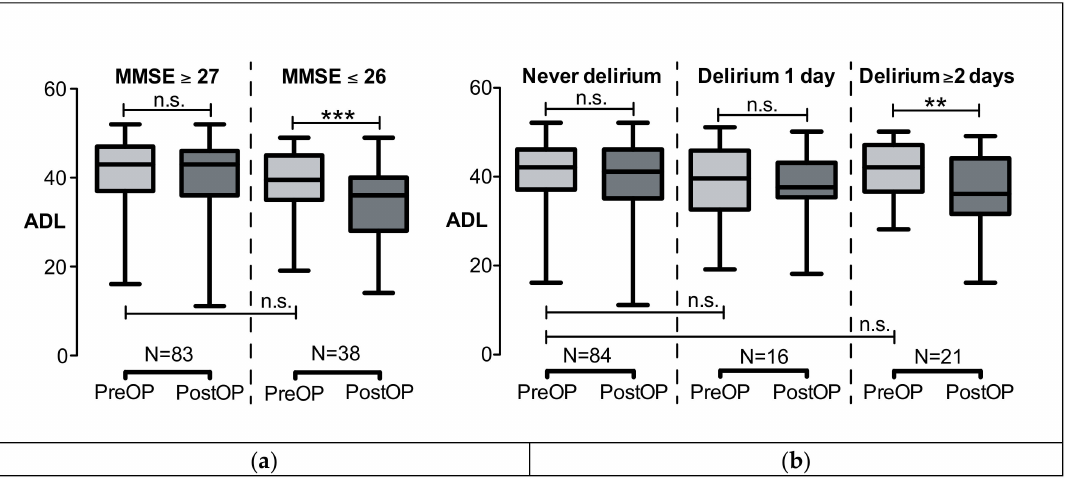
Figure 2. ADL before (preOP) and half a year after cardiac surgery and intensive care (postOP). ADL did not pre-operatively significantly di ff er between groups. ( a ) ADL was divided into MMSE ≥ 27 or MMSE ≤ 26 before surgery. ADL significantly declined only in the MMSE ≤ 26 group, ADL remained stable in the MMSE ≥ 27 group. ( b ) ADL was divided into whether patients had no delirium or 1 day or ≥ 2 days of delirium. ADL significantly declined if the delirium lasted ≥ 2 days. Data are shown as boxplots (median; minimum, maximum; 25% and 75% quartile). *** p < 0.001, ** p < 0.005; n.s., not significant. ADL, activity of daily living; MMSE, mini mental state examination.